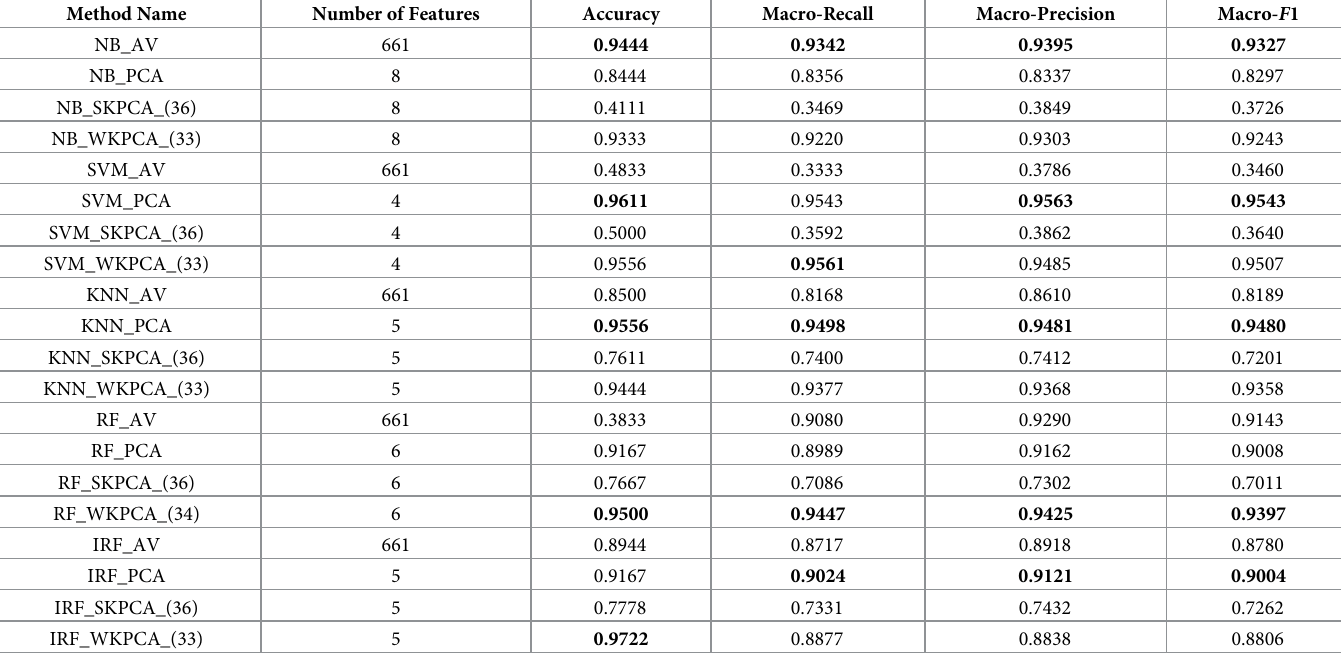
Table 4. Performance measurement comparisons of machine learning methods based on the DLBCL-B data set after WKPCA dimension